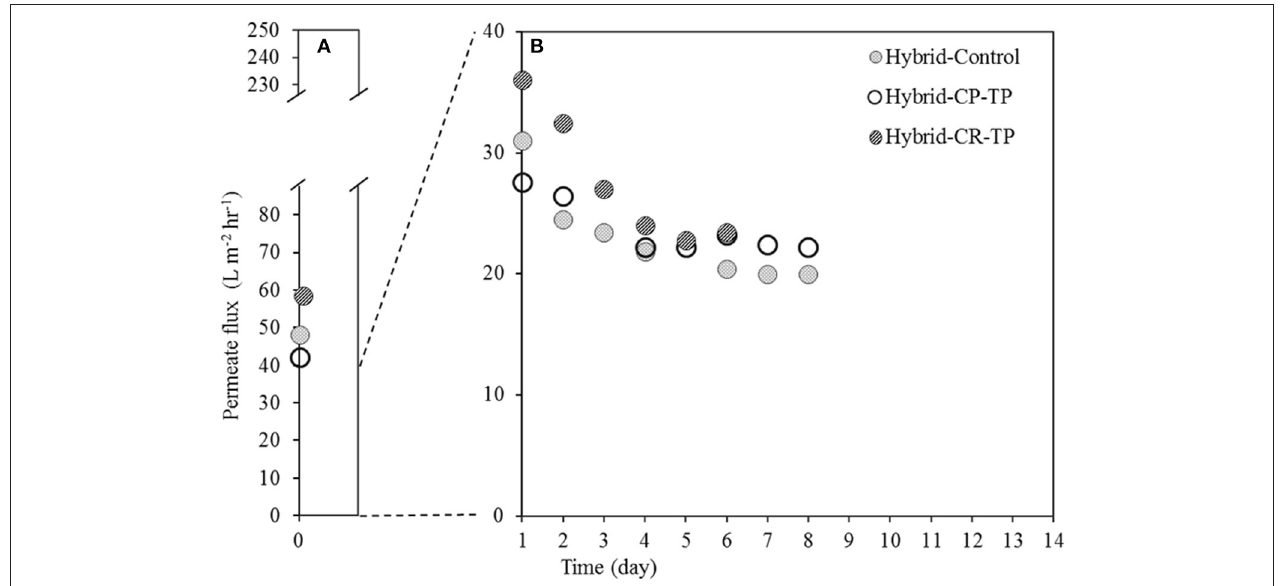
FIGURE 5 | Permeate fluxes on (A) Day 0 and (B) Day 1–14 as a result of operating BES integrated with AnMBR with crossflow filtration using polymeric membrane alone (Hybrid-Control) and polymeric membrane combined with a stainless steel mesh for hybrid anode configuration; with turbulence promotor (TP) application as fouling mitigation method, and the cathode located on the permeate side (CP) and retentate side